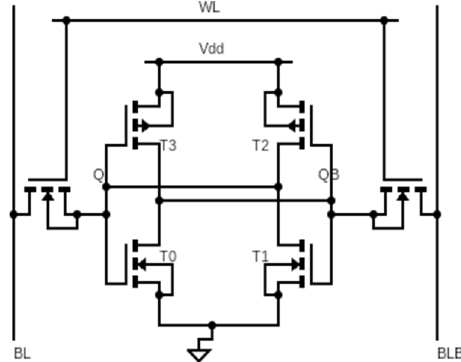
Figure 1. 6T SRAM cell